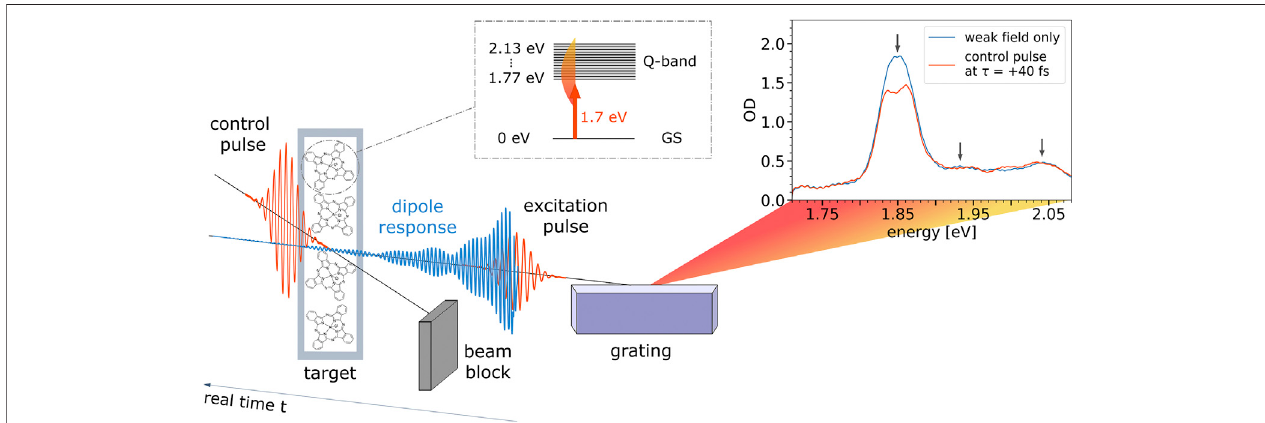
FIGURE 2 | Measurement concept. Pulses propagate from left to right, so, if considered temporally, real time increases from right to left. Therefore, the depicted pulse arrangement shows a con fi guration for positive delay times, where the delayed control pulse modi fi es the excitation-pulse-induced dipole moment (depicted in blue). Exemplary absorption spectra are shown for the case of very late control delays in blue (effectively “ weak fi eld only ” ) where the control pulse does not change the dipole response anymore, as well as for the time delay τ (cid:1) +40 fs, where the control pulse signi fi cantly perturbs the induced dipole moment. Black arrows denote the position of the Q3-, Q2-, and Q1-band. The inset shows an atom-like level scheme which is used for our toy model.